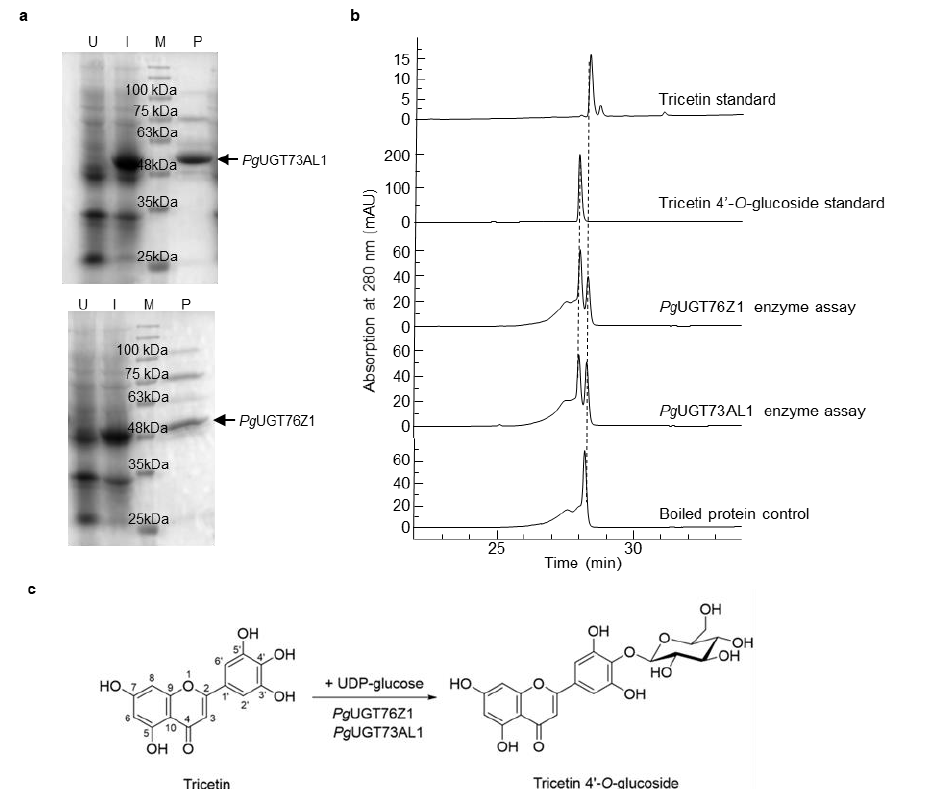
Figure 2. UGT protein expression and enzyme assays. ( a ) Expression and purification of Pg UGT73AL1 and Pg UGT76Z1 proteins. U, total lysate from uninduced E. coli cells transformed with the PgUGT73AL1 or PgUGT76Z1 plasmid construct; I, total lysate from E. coli cells transformed with the PgUGT73AL1 or PgUGT76Z1 plasmid construct and induced with 0.1 mM isopropyl β -D-1- thiogalactopyranoside; M, protein molecular mass marker; P, purified recombinant protein; kDa, kilodalton. ( b ) UGT enzyme activity assays with boiled UGT proteins (control) or purified recom- binant Pg UGT73AL1 and Pg UGT76Z1 proteins. ( c ) Glucosylation of tricetin by Pg UGT73AL1 and Pg UGT76Z1 to form tricetin 4 (cid:48) - O